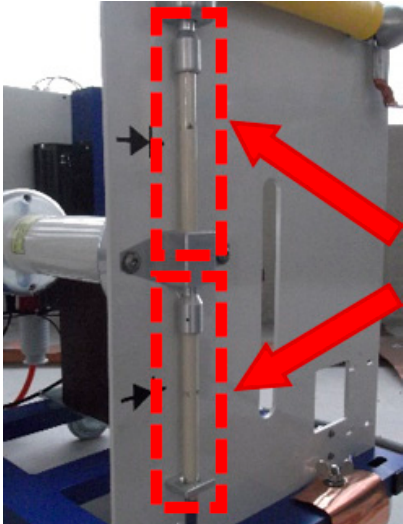
Figure 4. Charge unit diodes.